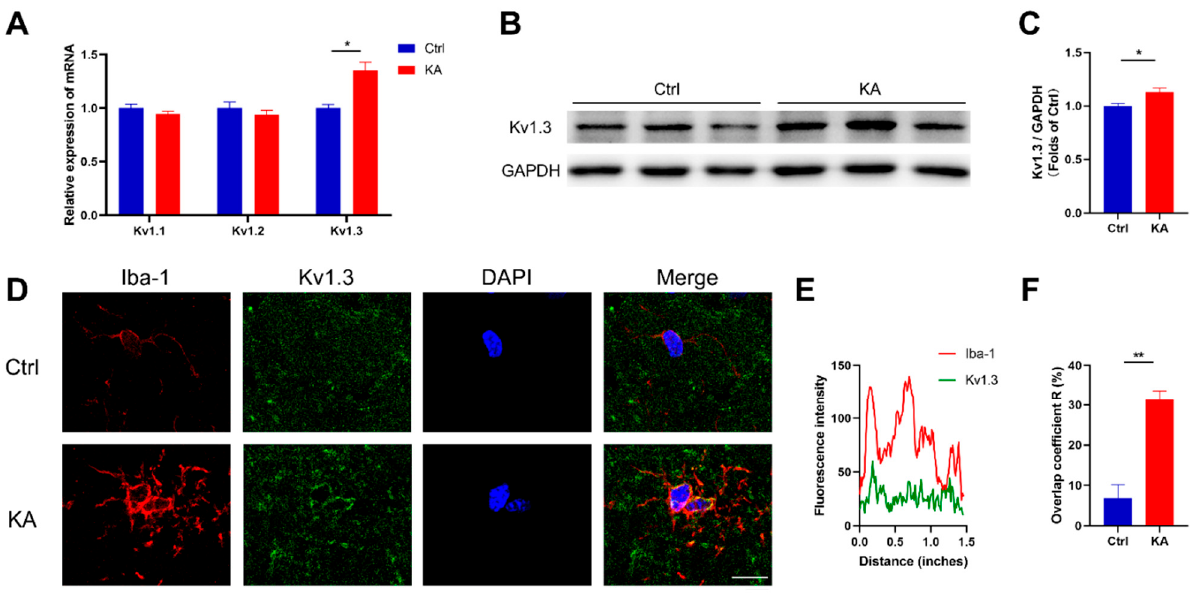
Figure 1. Kv1.3 was upregulated in microglia in KA-induced epileptic mice. ( A ) mRNA levels of potassium channels were detected in the brain of mice in Ctrl (n = 4 to 5) and KA (n = 9) groups; statistics by unpaired t -test. ( B , C ) Western blot analysis of Kv1.3 in the brain of mice in Ctrl and KA groups (n = 3); statistics by unpaired t -test. ( D – F ) Representative confocal images of Iba-1/Kv1.3/DAPI staining in the hippocampus of the two groups and colocalization analysis of Iba-1 and Kv1.3 (n = 3); statistics by unpaired t -test. Scale bar = 10 μ m. Data are depicted as the mean ± SEM. * p < 0.05, ** p < 0.01.